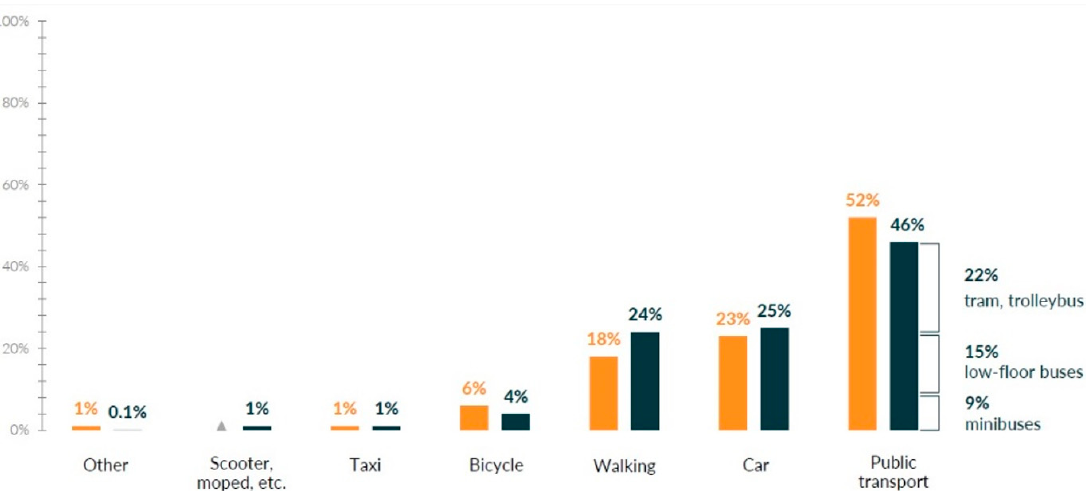
Figure 1. The ratio of users of different modes of transport in Lviv in the cold period of the year (2019—orange and 2021—black). Source: http://city-institute.org/content/uploads/2021/07/prezz_mob-2021-eng.pdf [25]. (accessed on 16 May 2022).